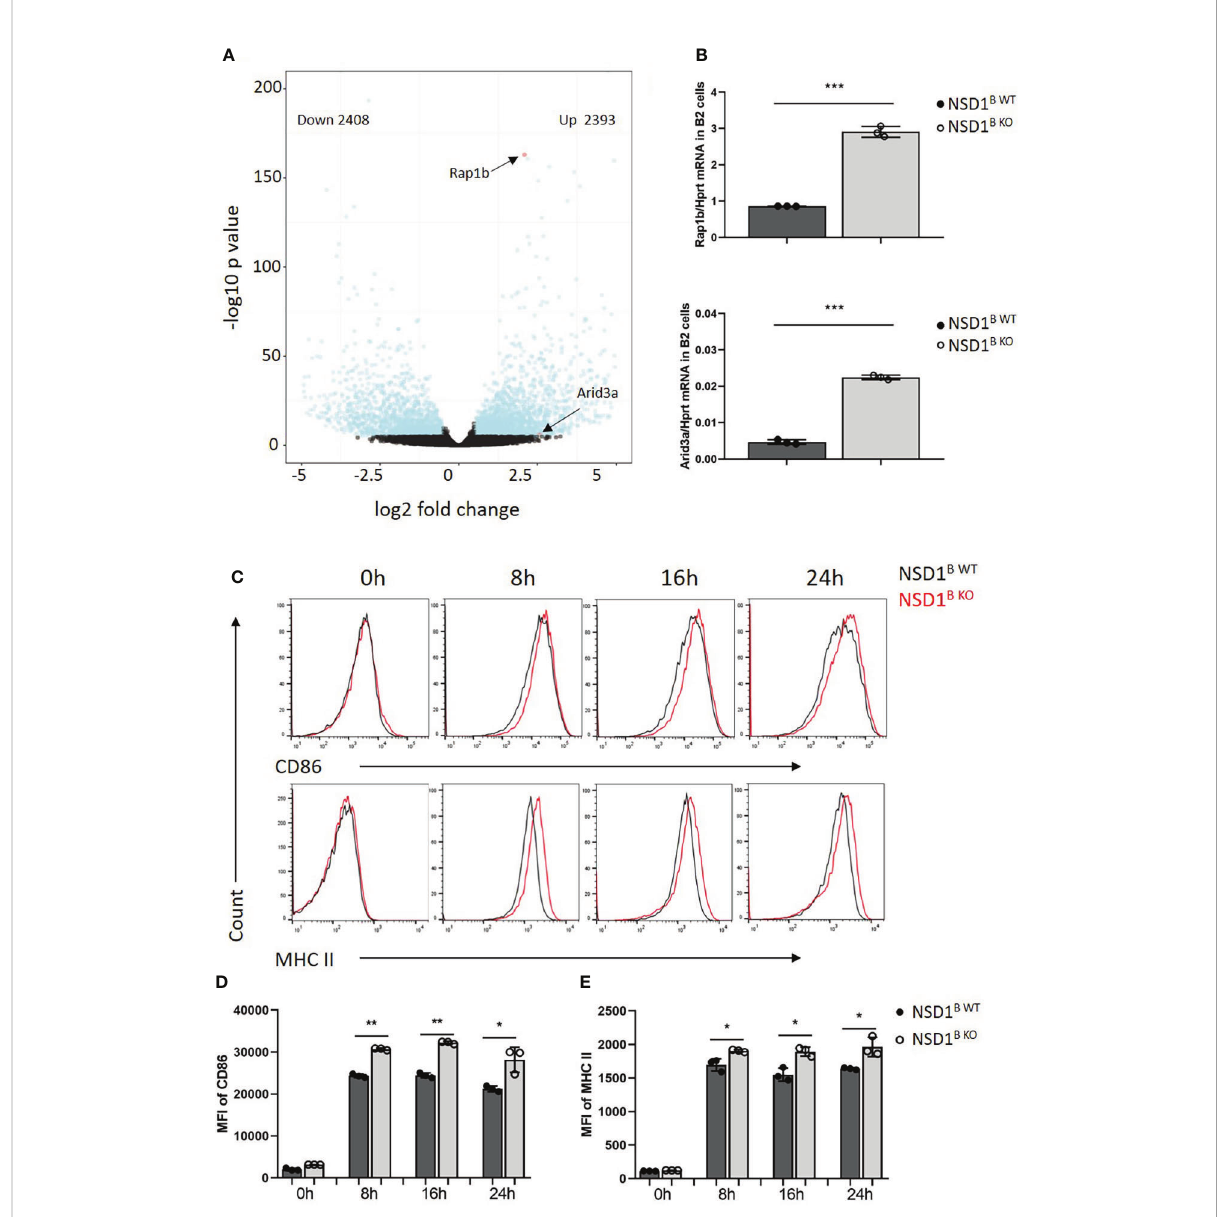
FIGURE 6 Rap1b and Arid3a promoted the development of B1 cells in NSD1 B KO mice (A) . RNA-seq analysis of B220 + B cells in the spleen from NSD1 B WT and NSD1 B KO mice. Differentially expressed genes (DEGs) (Padjust < 1e -5 and log2 [fold change] greater than 0.5 or less than -0.5) are shown in blue, and non-DEGs are shown in black. (B) . Q-PCR analysis of Rap1b (up) and Arid3a (down) expression in B220 + B cells. (C-E) . Histogram showing fl ow-cytometric analysis of CD86 and MHC II staining in B220 + B cells from spleen of NSD1 B WT and NSD1 B KO mice 8h, 16h and 24h after activation by IgM and CD40. Data are representative of 2 experiments. * P < 0.05, ** P < 0.01, *** P <